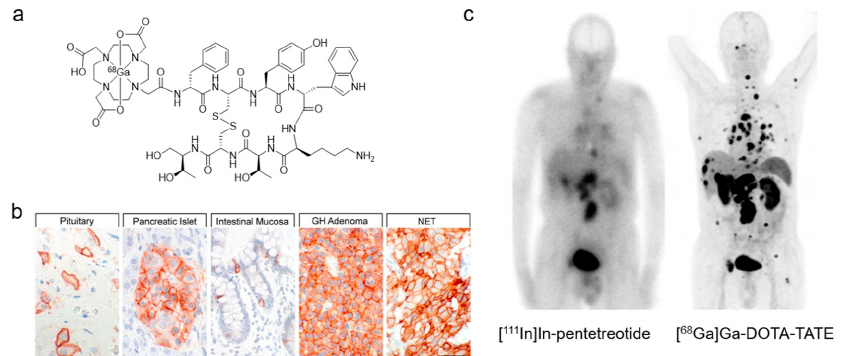
Figure 4. Somatostatin receptor imaging. ( a ) Chemical structure of [ 68 Ga]Ga-DOTA-TATE. ( b ) SSTR2 expression in normal tissues and neoplastic tissues. Reproduced with permissions from Pharmacol.